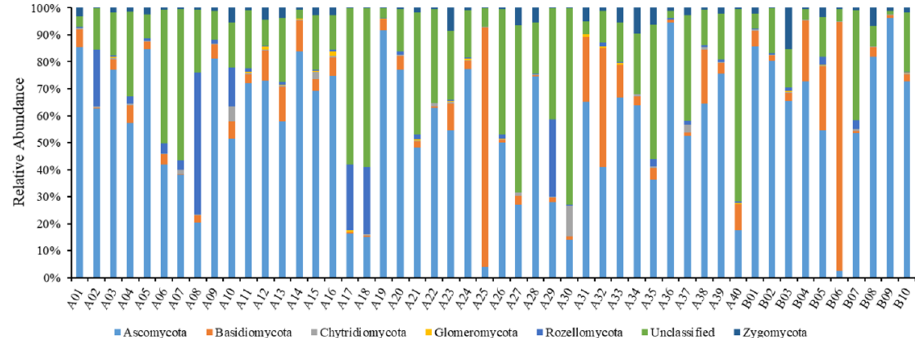
Figure 5. The relative abundance of soil fungi in all samples in the study area.